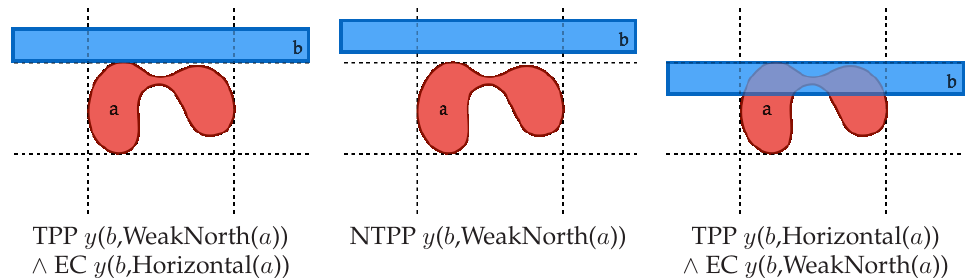
Figure 10: Direction relations with specified RCC-8 relations [35]. This approach provides a more flexible framework for describing further elements of object b ’s position relative to object a , but prior work does not focus on the gains that can be realized from a reasoning perspective by taking this approach.